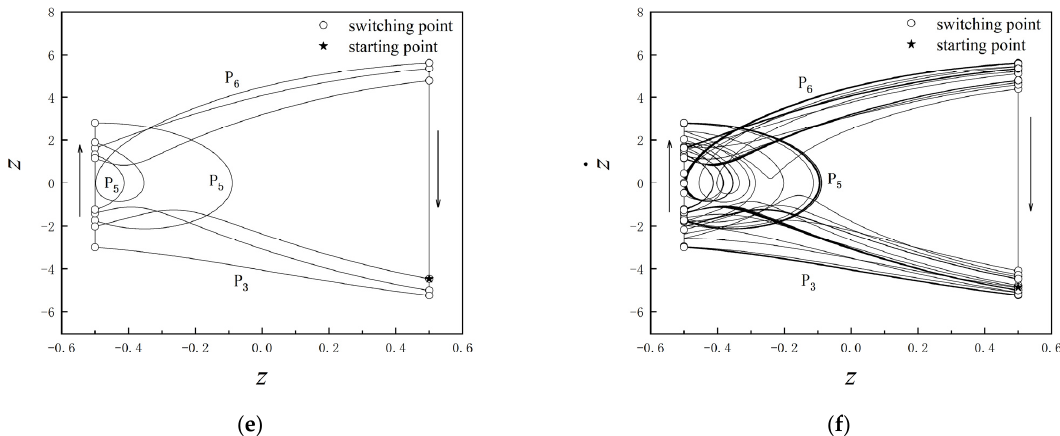
Figure 7. The grazing bifurcation. ( a ) e = 0.605, ( b ) e = 0.606, ( c ) e = 0.742, ( d ) e = 0.743, ( e ) e = 0.934, ( f ) e = 0.935.